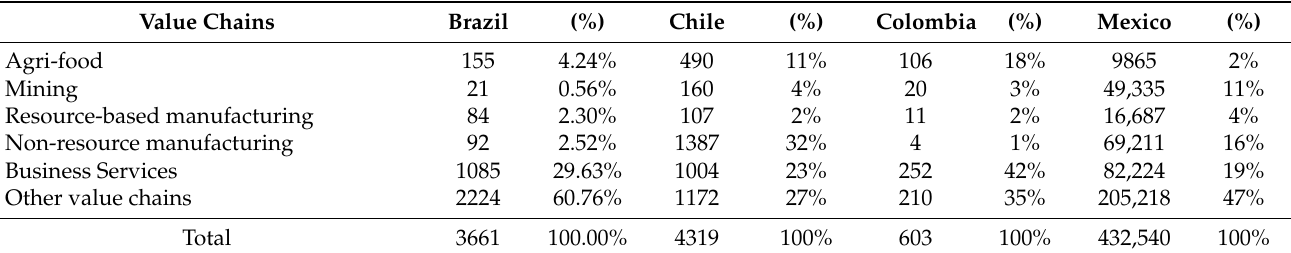
Table 5. TiVA measures 1 : From selected Value Chains to meet the final demand (domestic and